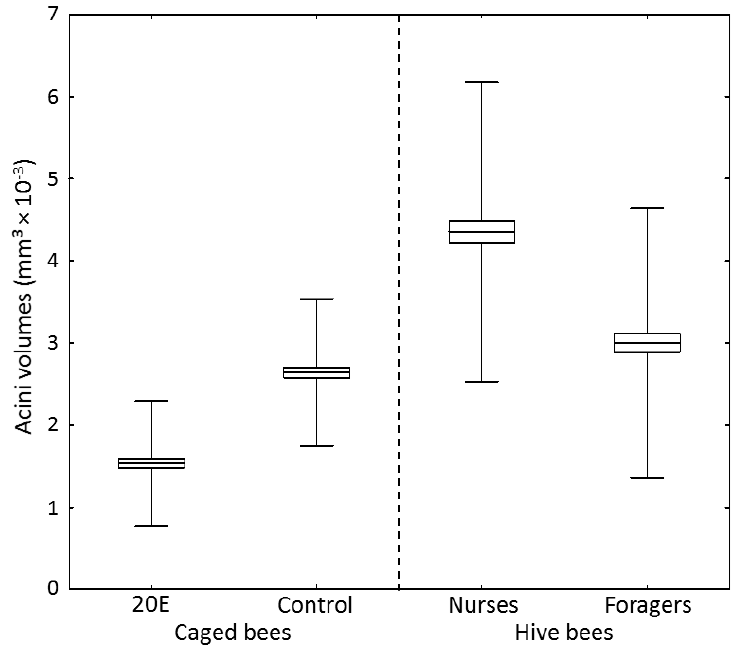
Figure 3. Acini volumes of 10-day-old nurse bees, 24-day-old forager bees, and caged bees of the control group and the 20E group ( n = 10 bees with 20 acini measured per bee). Acini volumes were calculated as described in [36]. Boxes show means ± SEs and whiskers show SDs.